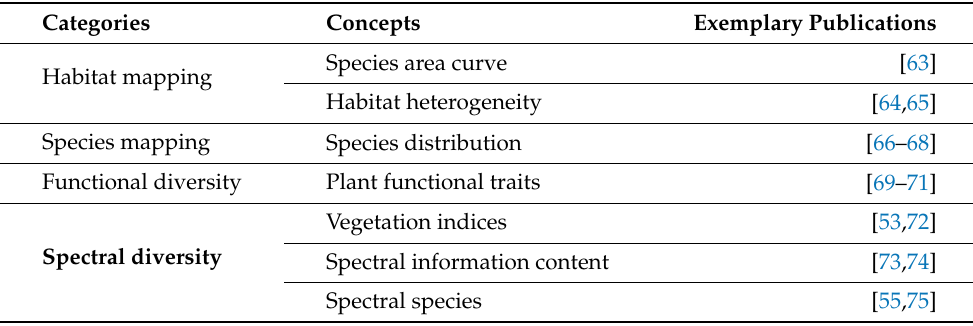
Table 2. Classification of categories for biodiversity monitoring from remote sensing imagery accord- ing to Wang & Gamon 2019